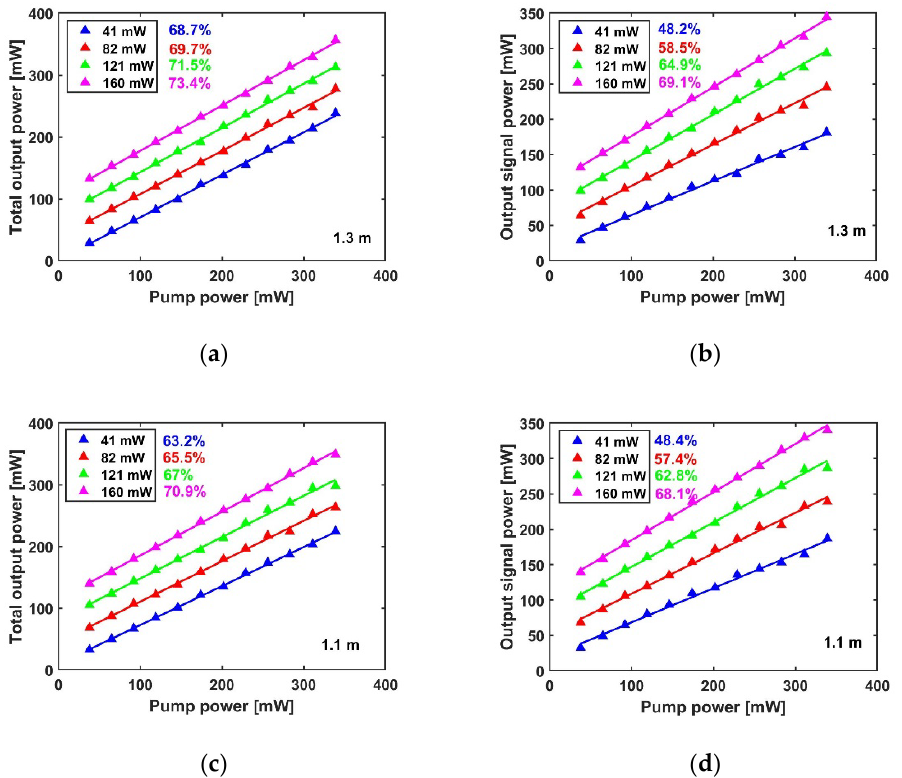
Figure 9. The variation in output power and signal power with pump power. Active fiber length: ( a , b ) 1.3 m; ( c , d ) 1.1 m. Pump thresholds with seed powers from 41 mW to 160 mW: 1.3 m: (51.4 mW; 59.7 mW; 68.4 mW; 76.7 mW); 1.1 m: (43.6 mW; 53.4 mW; 58.9 mW; 64.1 mW).